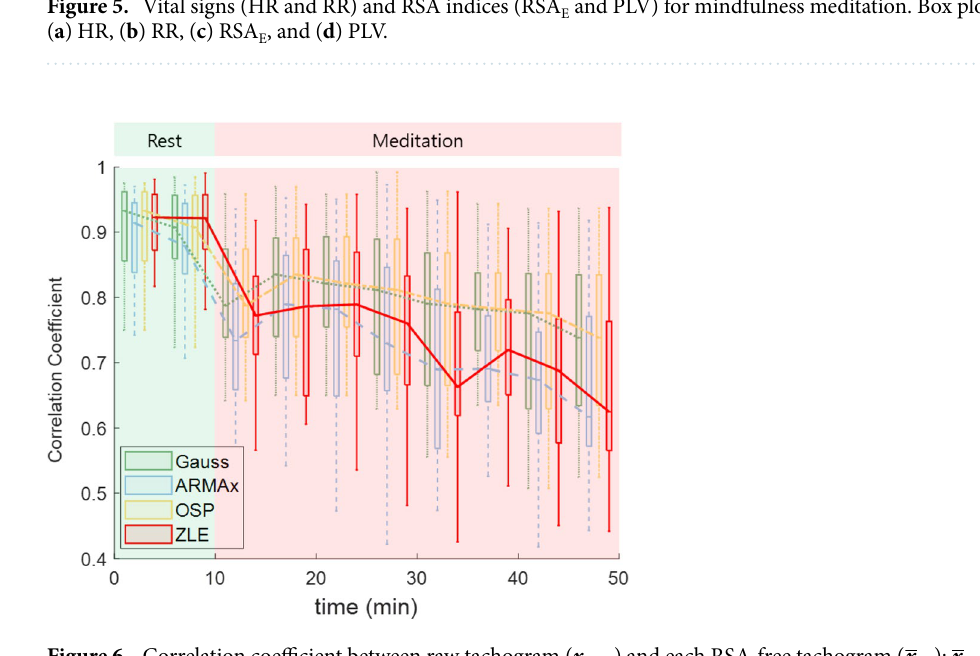
Figure 6. Correlation coefficient between raw tachogram ( x RAW ) and each RSA-free tachogram ( x R-f ); x R-f of Gauss (green boxes and dotted line); x R-f of ARMAx (blue boxes and dashed line); x R-f of OSP (yellow boxes and dash-dotted line); x R-f of ZLE (red boxes and solid